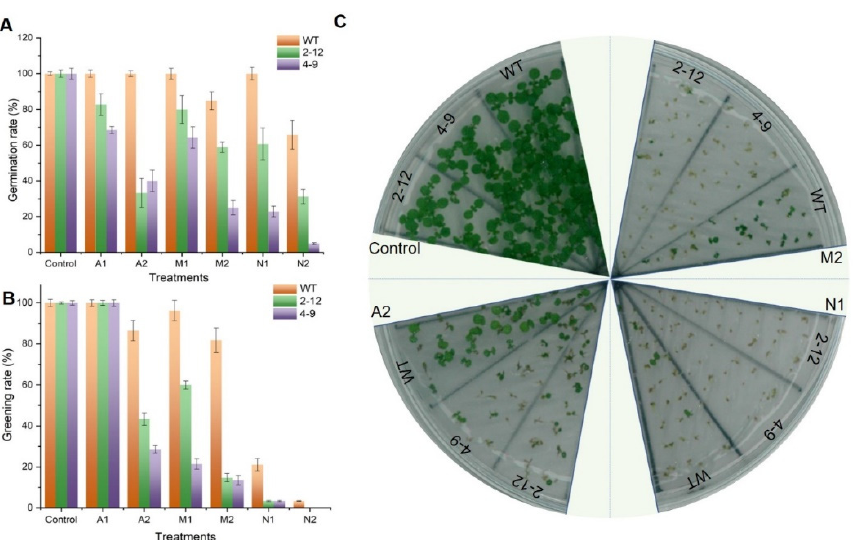
Figure 6. The increased sensitivity of SlBAG9 -overexpressing Arabidopsis to mannitol, NaCl, and ABA stress. ( A ) The germination rate of SlBAG9 -overexpressing lines (2–12 and 4–9) and wild type (WT) on 1/2 MS medium containing 200 and 300 mM mannitol (M1, M2), 175 and 200 mM NaCl (N1, N2), and 1.0 and 1.5 µM ABA (A1, A2) treatments for 5 days. ( B ) Cotyledon greening rate of SlBAG9 -overexpressing lines and WT on 1/2 MS medium containing 200 and 300 mM mannitol (M1, M2), 175 and 200 mM NaCl (N1, N2), and 1.0 and 1.5 µM ABA (A1, A2) treatment for 10 days. Error bars indicate the SD of three replicated experiments. ( C ) The seedling growth of SlBAG9 -overex- pressing lines and WT Arabidopsis on 1/2 MS plates containing 300 mM mannitol (M2), 175 mM NaCl (N1), and 1.5 µM ABA (A2) treatments for 10 days.